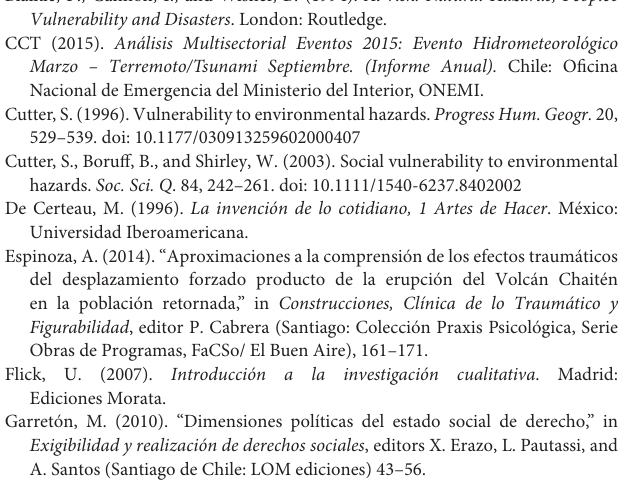
Figurabilidad , editor P. Cabrera (Santiago: Colección Praxis Psicológica, Serie Obras de Programas, FaCSo/ El Buen Aire),